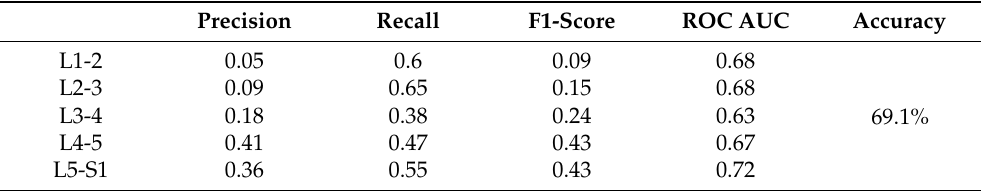
Table 5. Evaluation results of the final deep learning model using the test set for predicting HNP presence in each lumbar